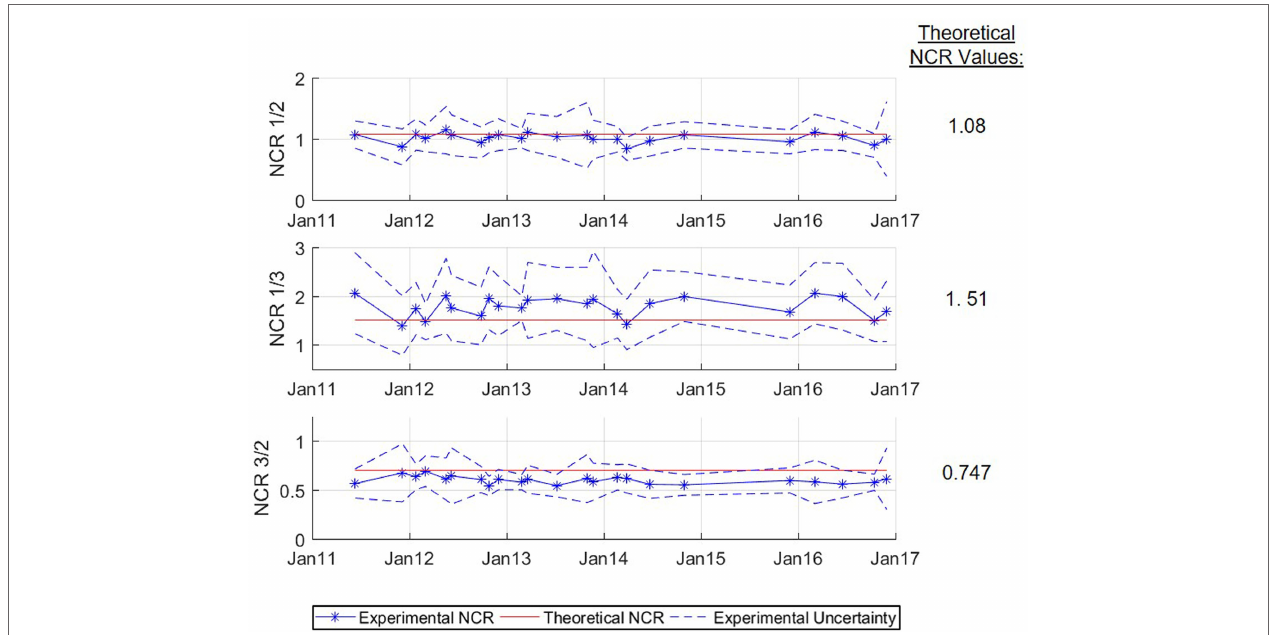
FIGURE 14 | NCR calculated using data collected from the